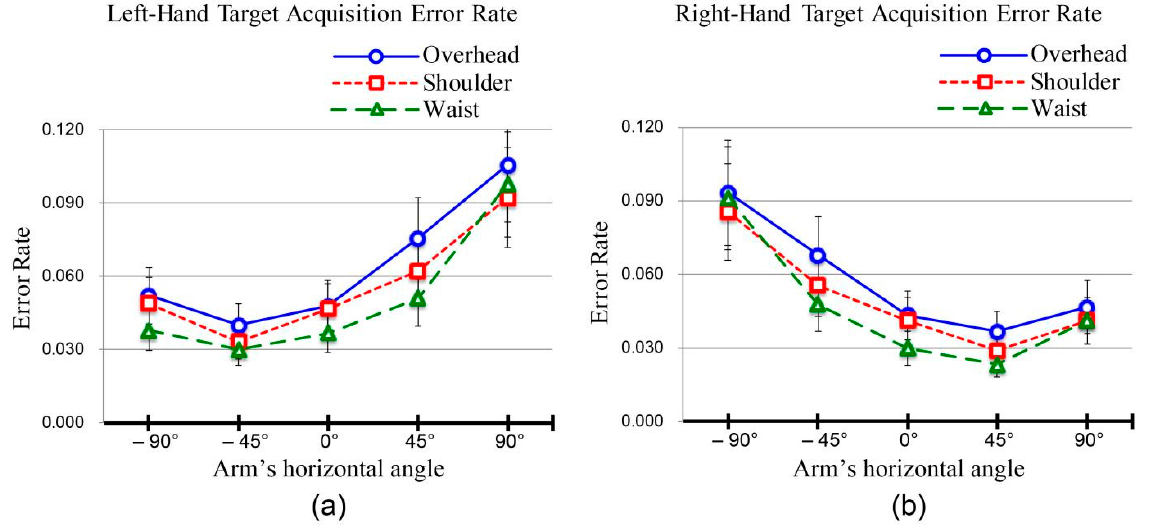
Figure 6. Target acquisition error rate at different heights by either hand: ( a ) left-hand interaction result; ( b ) right-hand interaction result.